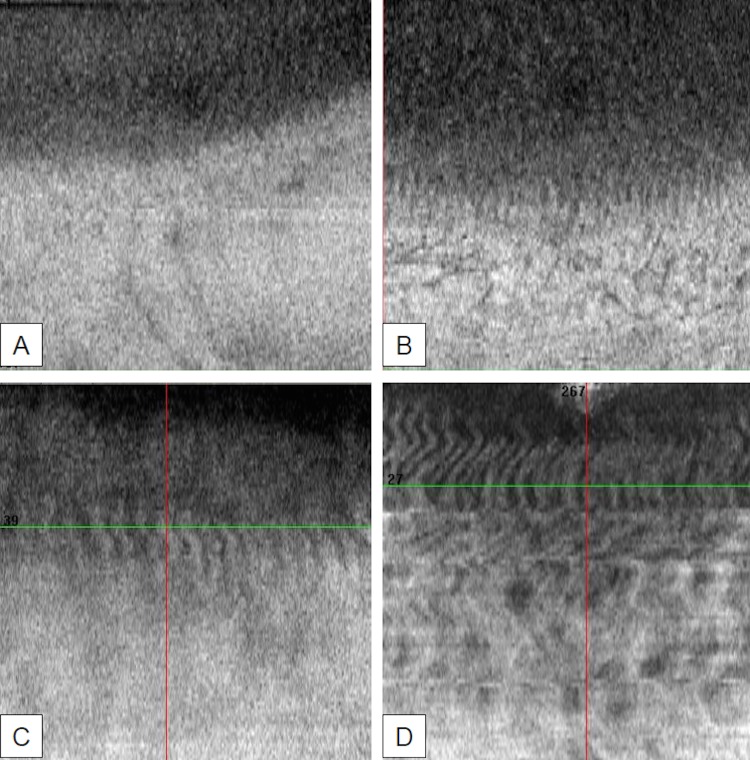
En-face OCT limbal features with corresponding grade.Palisades of Vogt are clearly identified as a network of radially oriented, channel-like and high reflective features located in the superficial corneoscleral limbus. A shows grade 0 (no visualization of palisades of Vogt) B shows grade 1 (low visualization of palisades of Vogt) C shows grade 2 (intermediate visualization of palisades of Vogt) D shows grade 3 (high visualization of palisades of Vogt).